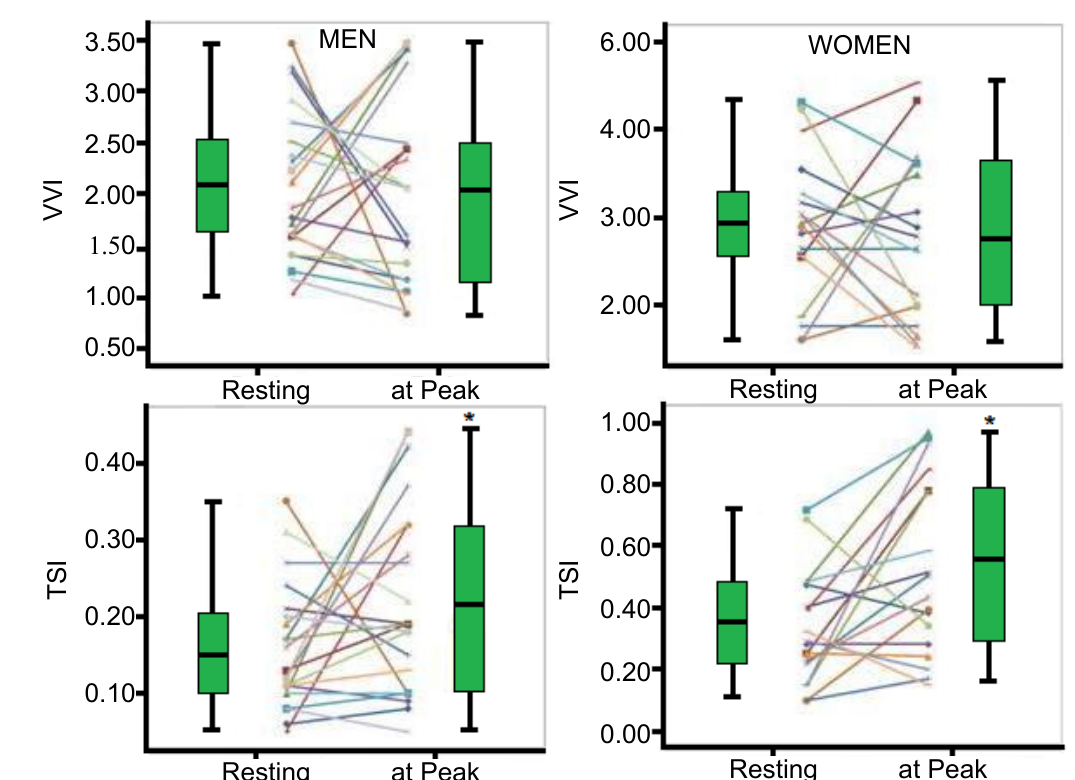
Figure 3 At rest and exercise stages, TSI and VVI were compared by boxplot in women and men respectively. Solid bar in the box represents median value. Exercise-induced changes of TSI and VVI were shown by line graph.